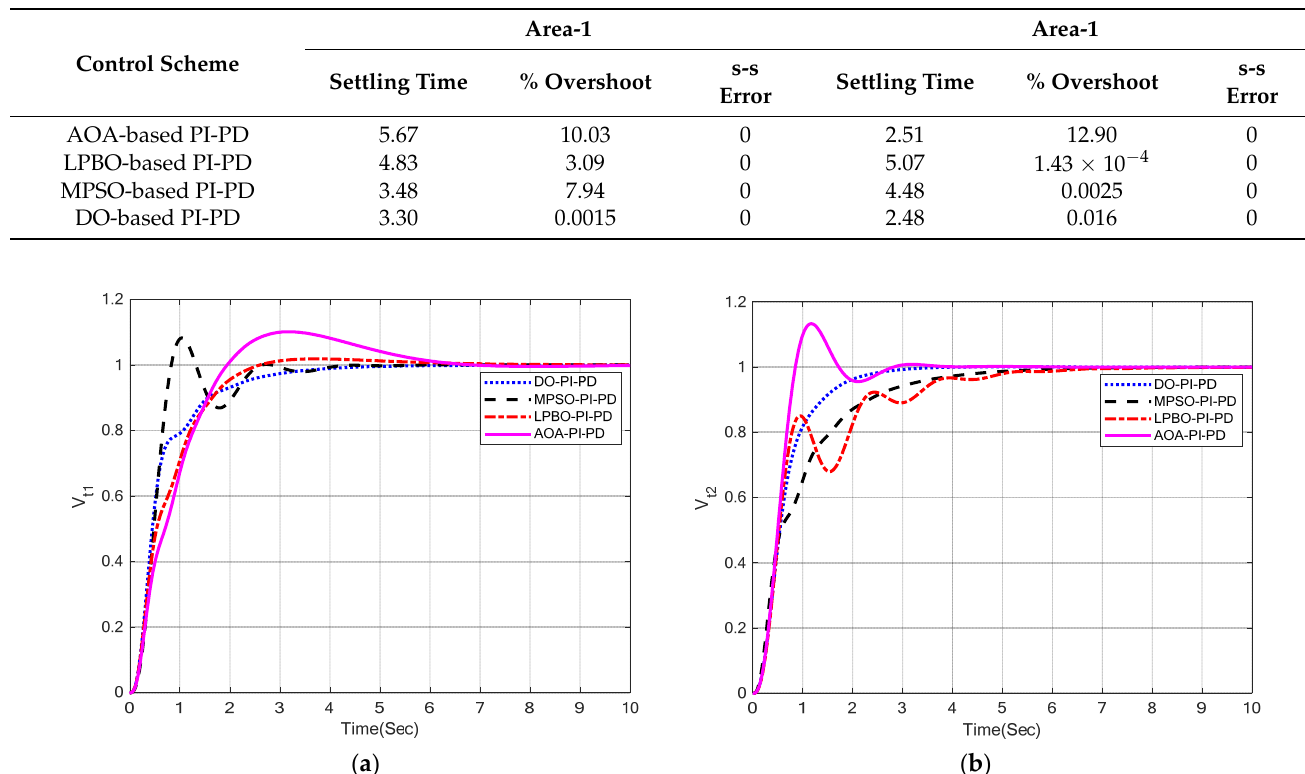
Table 10. Numerical results of an AVR in a two-area multi-source realistic IPS with nonlinearities.